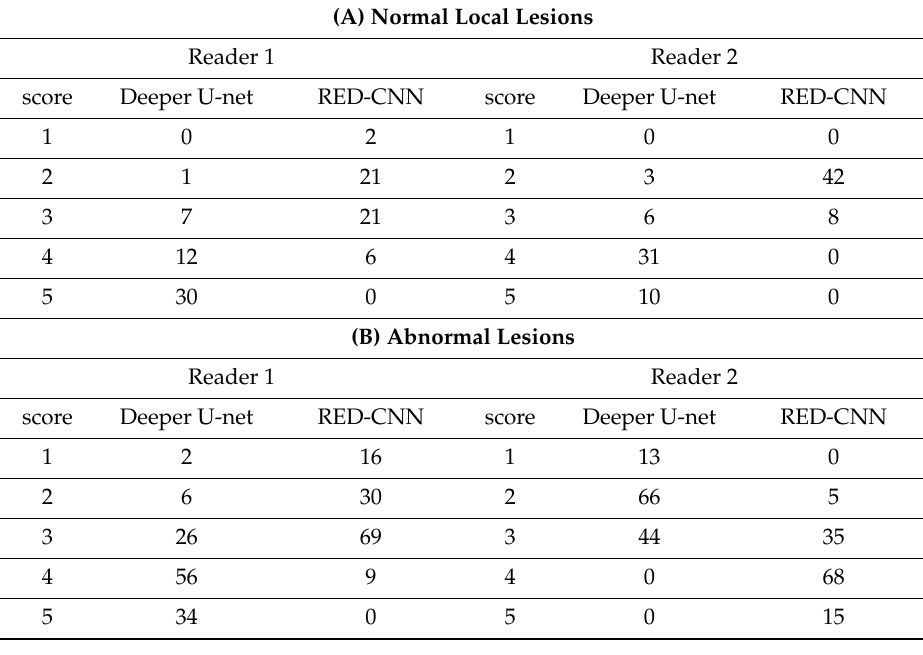
Figure 5. Visual evaluation of normal local lesions and abnormal lesions by the two readers using different deep learning algorithms.